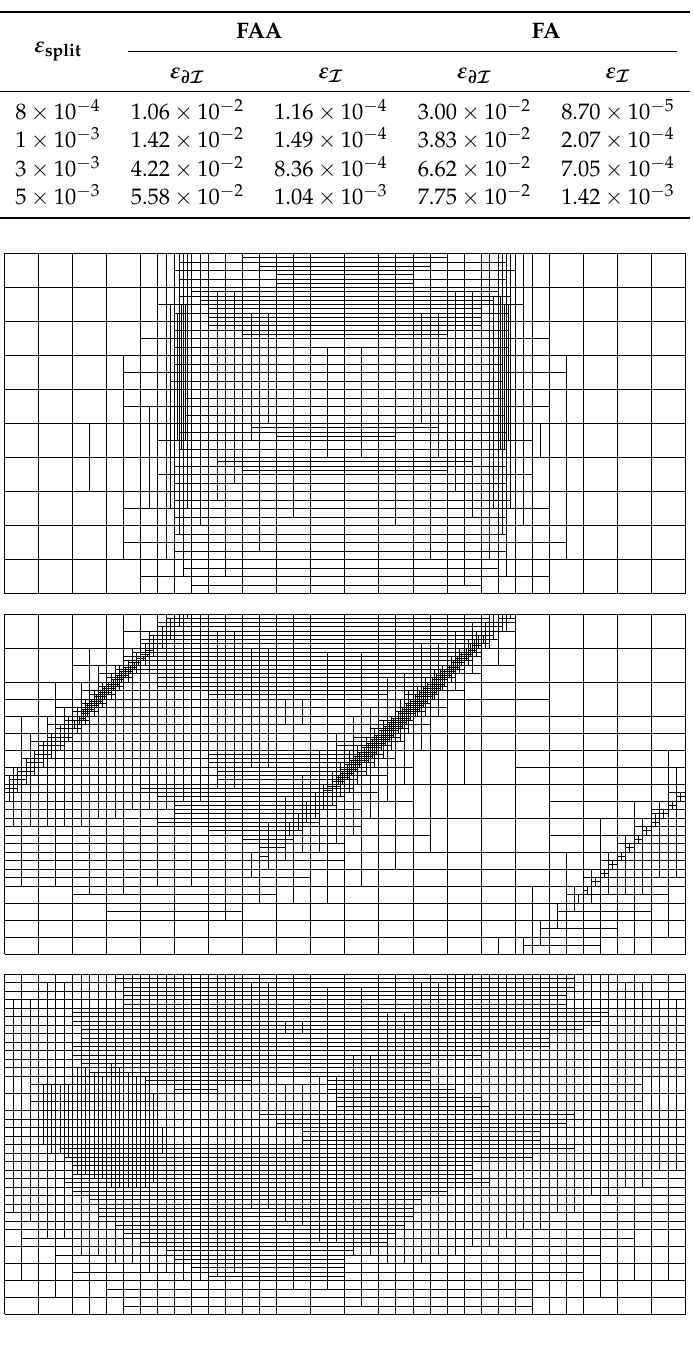
Figure 5. Adaptive grids in the plane y = L y /2 corresponding to the linearized forward-adjoint approach with θ 0 m = 0 ◦ (upper panel) and θ 0 m = 45 ◦ (middle panel), and the linearized forward approach (lower panel). The solar azimuthal angle is ϕ 0 = 0 ◦ . The horizontal axis is the x -axis, while the vertical axis is the z